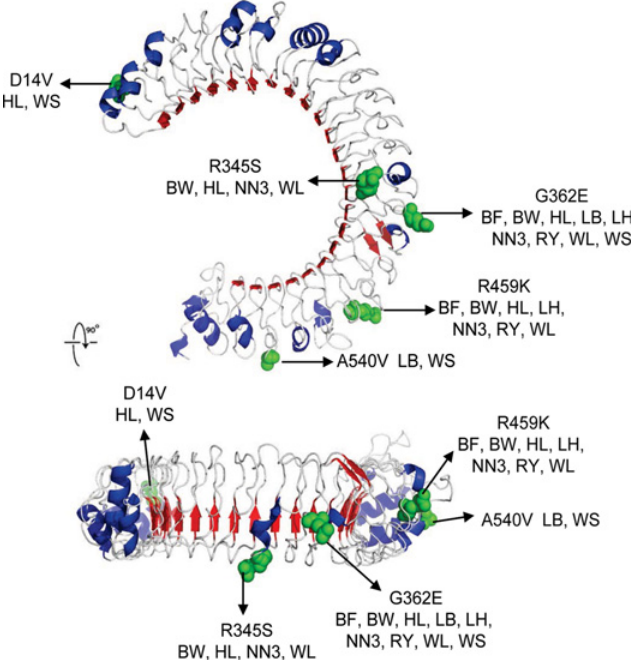
Fig 1. Visualization of amino acids corresponding to nonsynonymous single nucleotide polymorphism in extracellular domain of chicken TLR3 based on the protein structure predicted by CPHmodels 3.0 Server (www.cbs.dtu.dk). BF = Beijing Fatty chicken, BW = Beijing White 939 chicken, HL = Hy-Linevarietybrown chicken, LB = Laiwu Black chicken, LH = Luhua chicken, NN3 = Nongda No. 3 chicken, RY = Royal chicken, WL = White Leghorn chicken, WS = White-Feather Silky chicken.